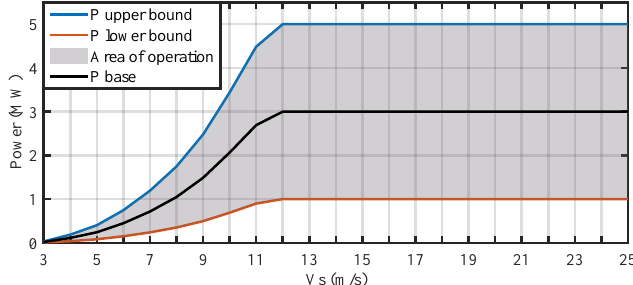
Figure 6. Control design for 40%